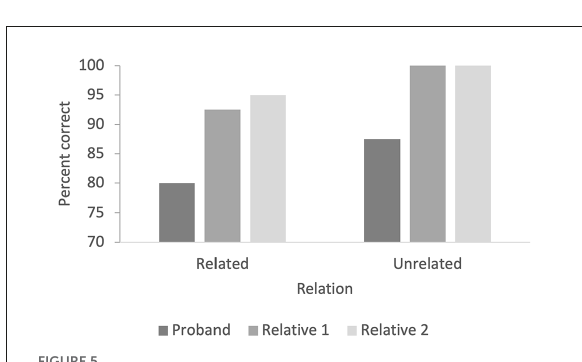
FIGURE5 The figure indicates the percentage of correct responses in related and unrelated pairs for the priming test with words. measures: intracranial volume, total cortical surface area, and mean cortical thickness. These analyses showed that the 3q29 carrier had smaller intracranial volume and total cortical surface area relative to the healthy controls (25th and 14th percentiles, respectively) and the unaffected family members ( Table 1 ).